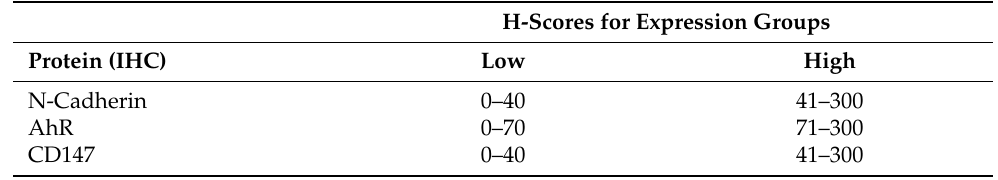
Table 1. H-score cut-offs for N-cadherin, AhR and CD147 groups of expression. H-Scores for Expression